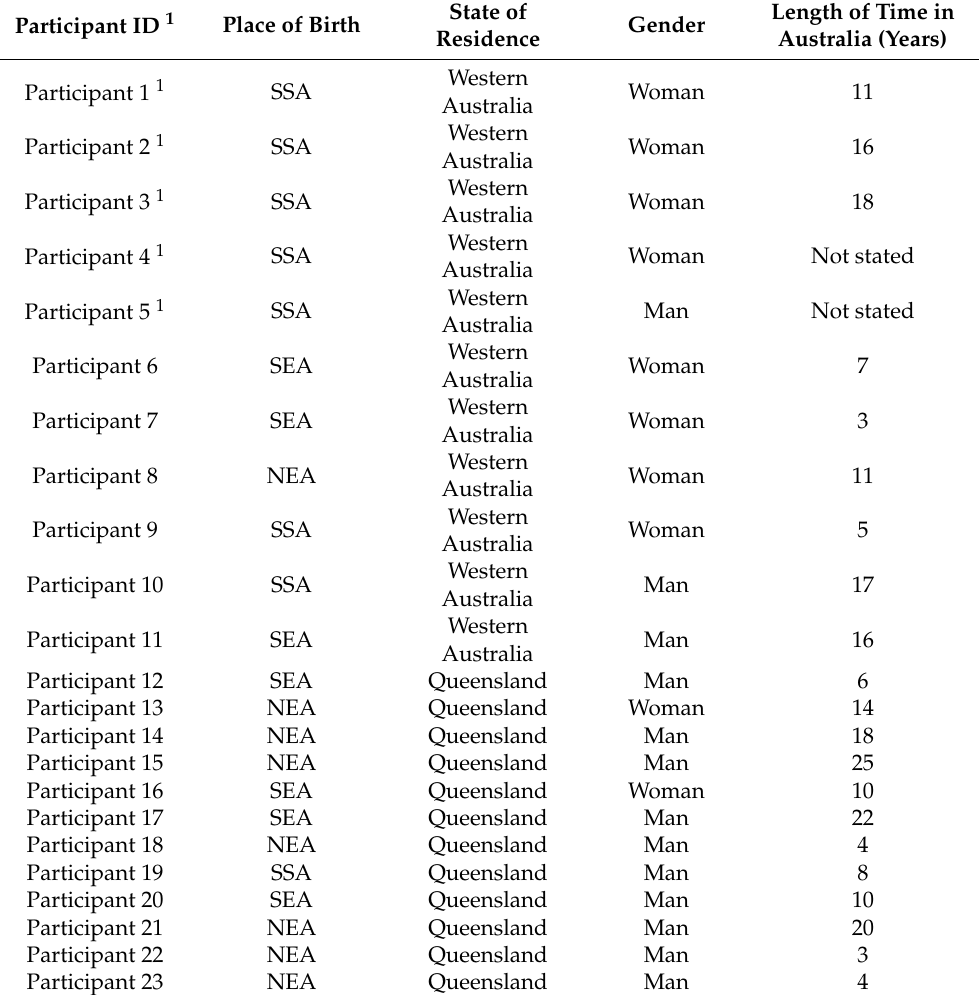
Table 2. Characteristics of participants in qualitative component of